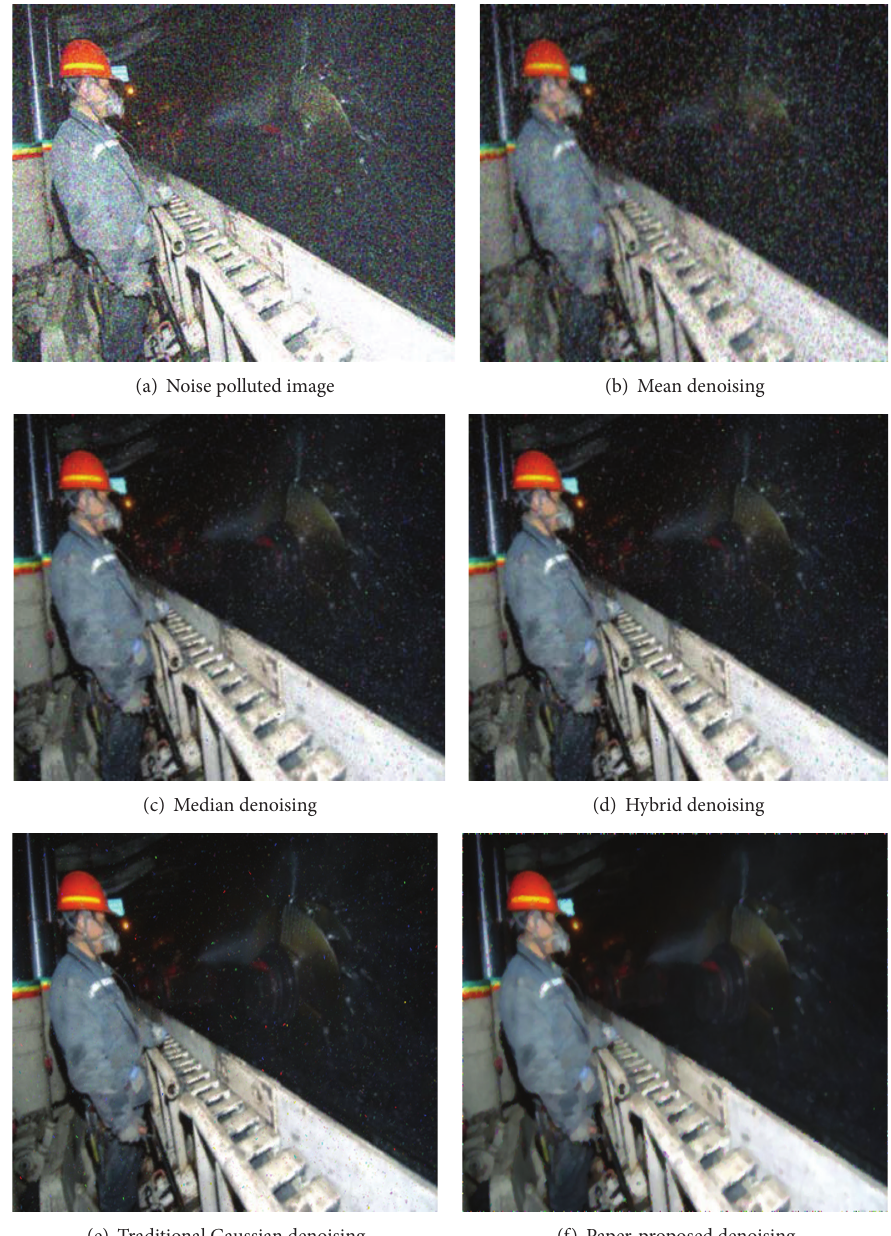
Figure 4: Effect contrast of different denoising